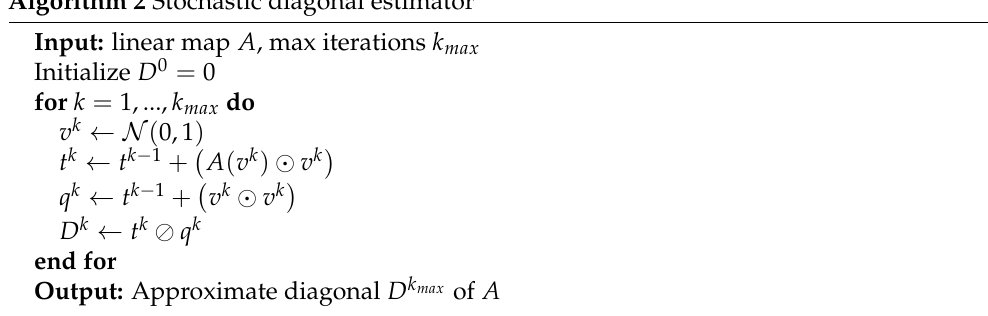
Algorithm 2 Stochastic diagonal